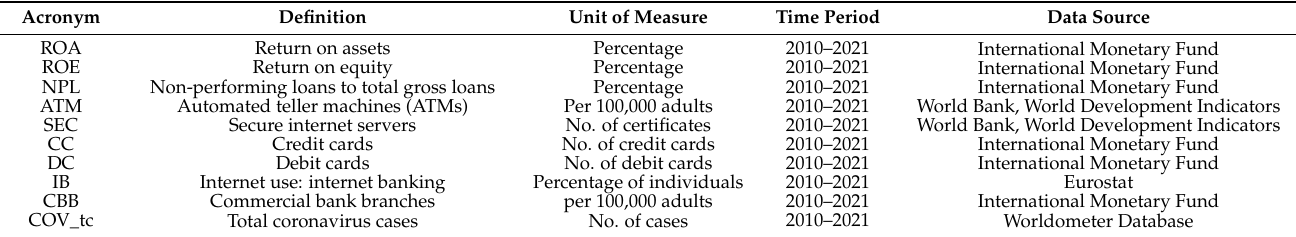
Table 1. Variables and data